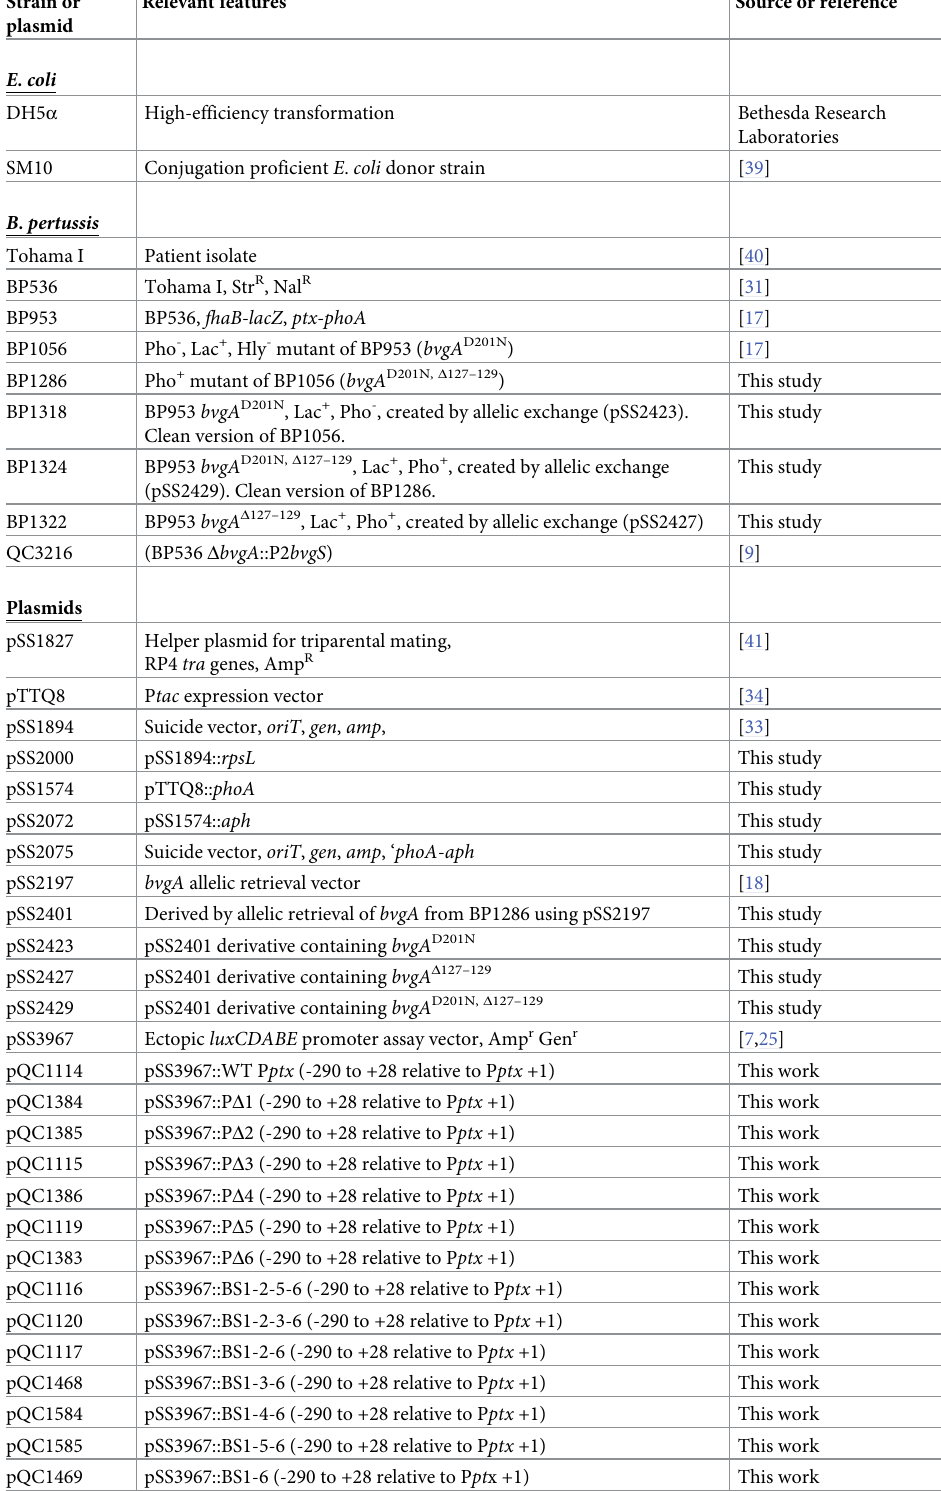
Table 1. Strains and plasmids used in this